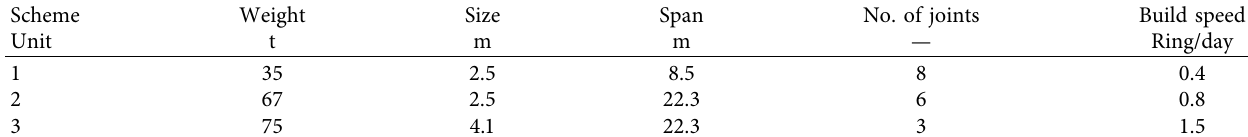
Table 4: The comprehension comparison of the three schemes.